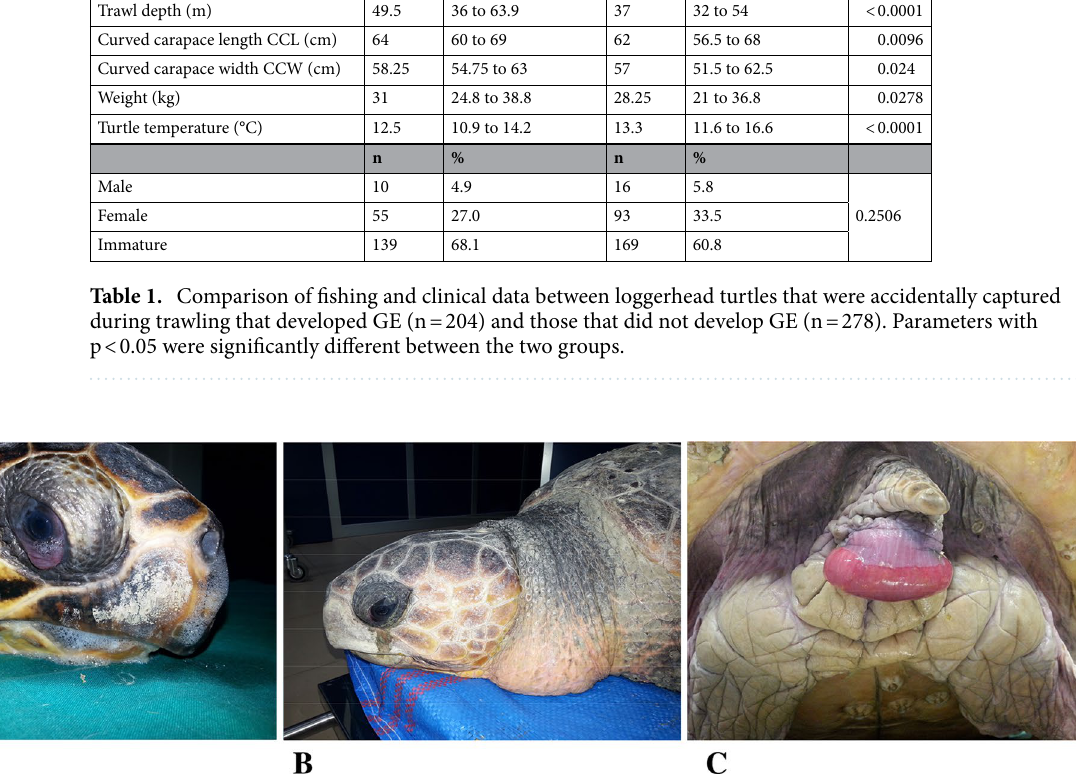
Figure 2. Clinical findings in turtles with GE. ( A ) Eyelid and conjunctival oedema and external foam coming from ramphotheca and nostrils in a Loggerhead turtle ( Caretta caretta ) with GE and drowning; ( B ) prominent oedema of the eyelid and neck; ( C ) prolapse of the cloaca in Caretta